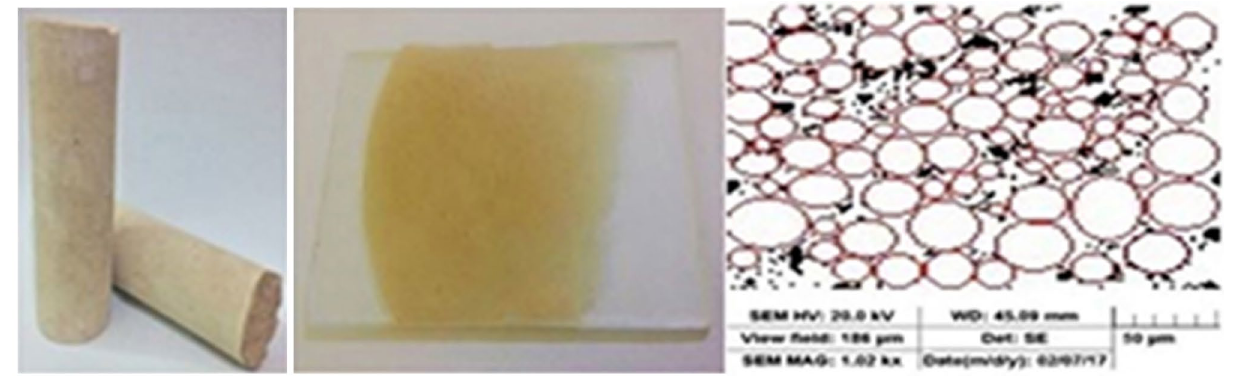
Fig. 2 Steps of preparing micromodels; a core sample, b thin section, c SEM